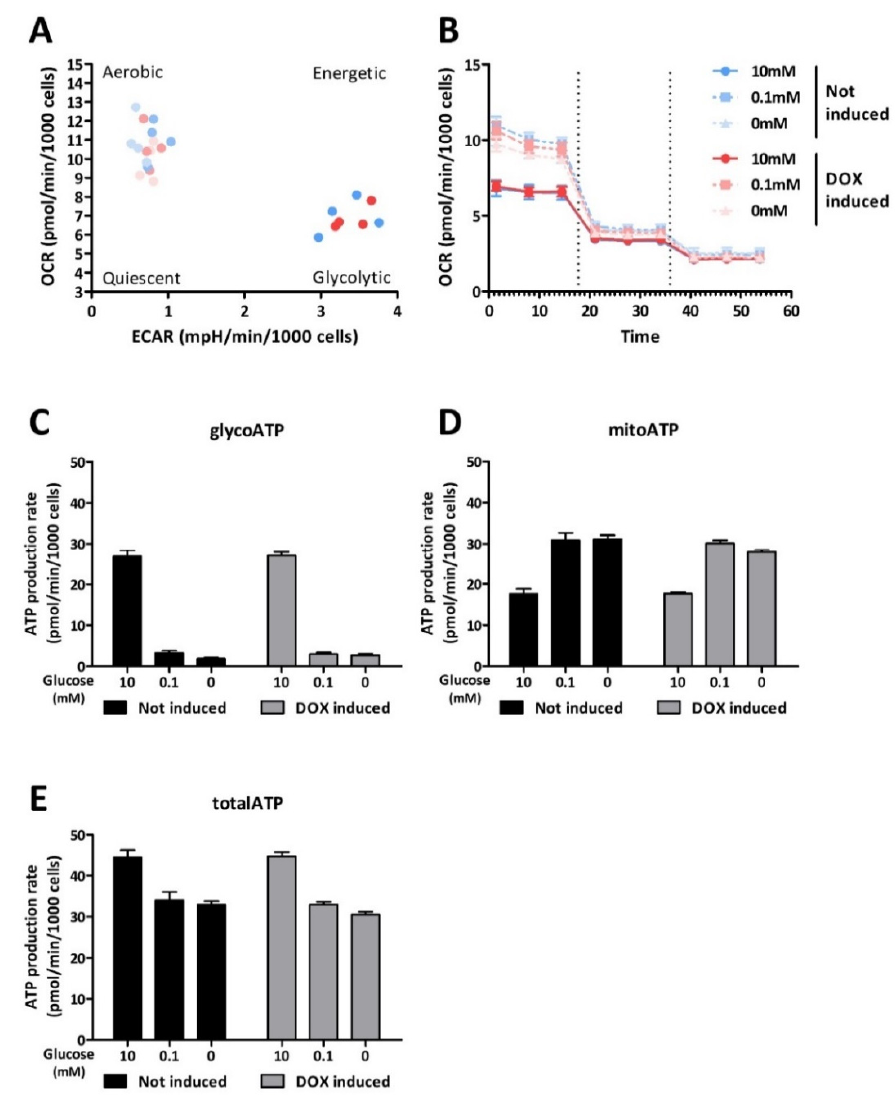
Figure 6. Metabolic profiling and ATP production rate of C6-rtTA-AMPK-DN cells. The oxygen consumption rate (OCR) and the extracellular acidification rate (ECAR) were measured using the Seahorse XFe96 flux analyzer. The rate of ATP production in C6-rtTA-AMPK-DN cells was quantified by real-time ATP rate assay following 6 h of severe (0.1 mM) or total (0 mM) glucose deprivation. Data from four biological replicates are presented as means ± SEM. ( A ) Energetic map of not induced (blue) and DOX-induced (red) cells in all conditions tested. All replicates are represented on the dotted plot. ( B ) Kinetic profile of the OCR measurements. ( C , D , E ) Histograms show